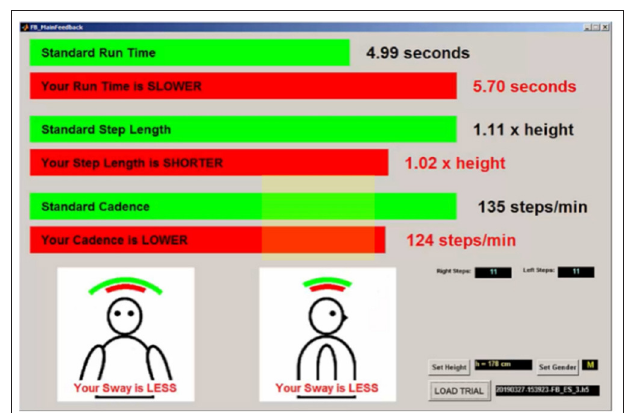
FIGURE 1 | Sample biomechanical feedback presented to Phase II participants. Green bars indicate the sex-matched gold standard data. Red bars indicate the participant’s performance for that trial. The rows display participant run time, step length, and cadence (i.e., step frequency). Step length is normalized to the participant’s height. For trunk sway, the green arcs show the side-to-side and front-to-back gold standard trunk sways. The red arcs show the participant’s